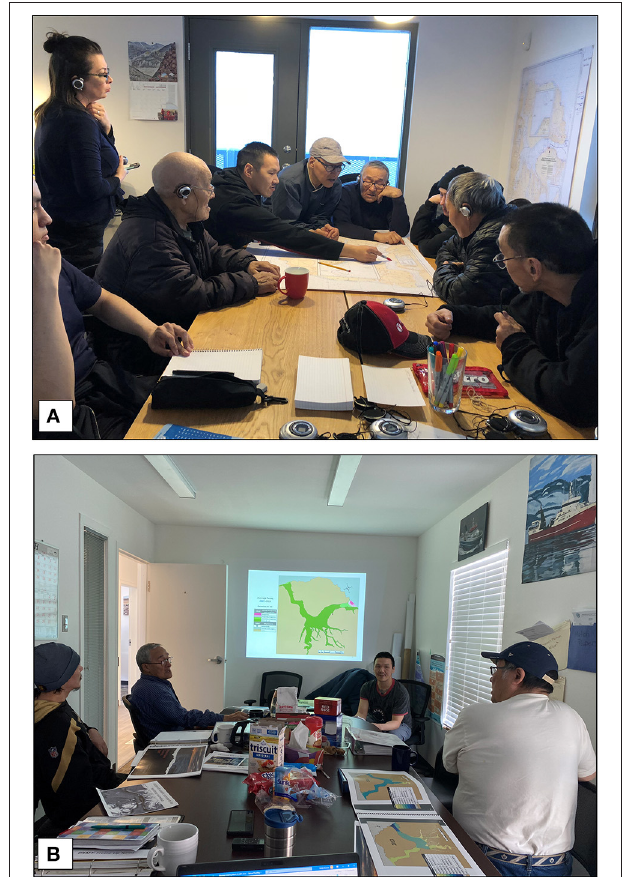
FIGURE 2 | (A) Sikumiut members mapping their sea ice IQ, November 2018. Photo credit Katherine Wilson. (B) Sikumiut members reviewing the Mittimatalik siku asijjipallianinga maps, March 2021. Photo credit Shelly